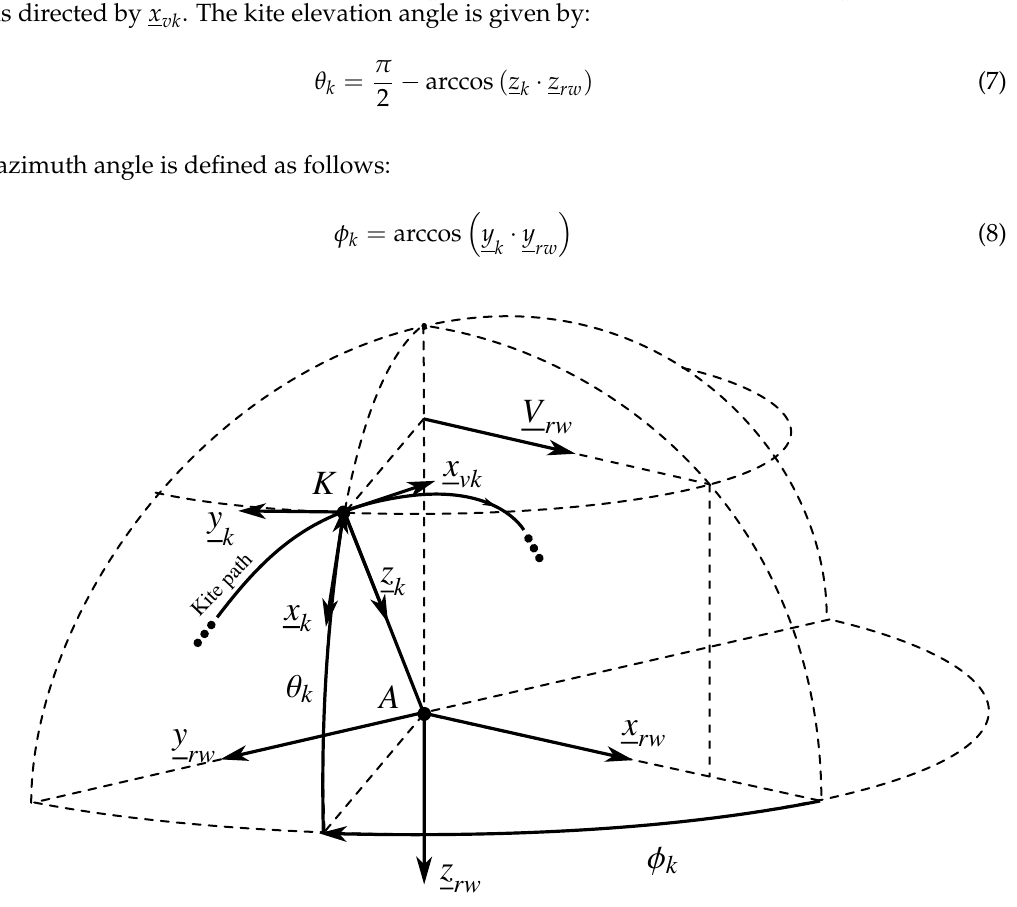
Figure 2. Kite reference